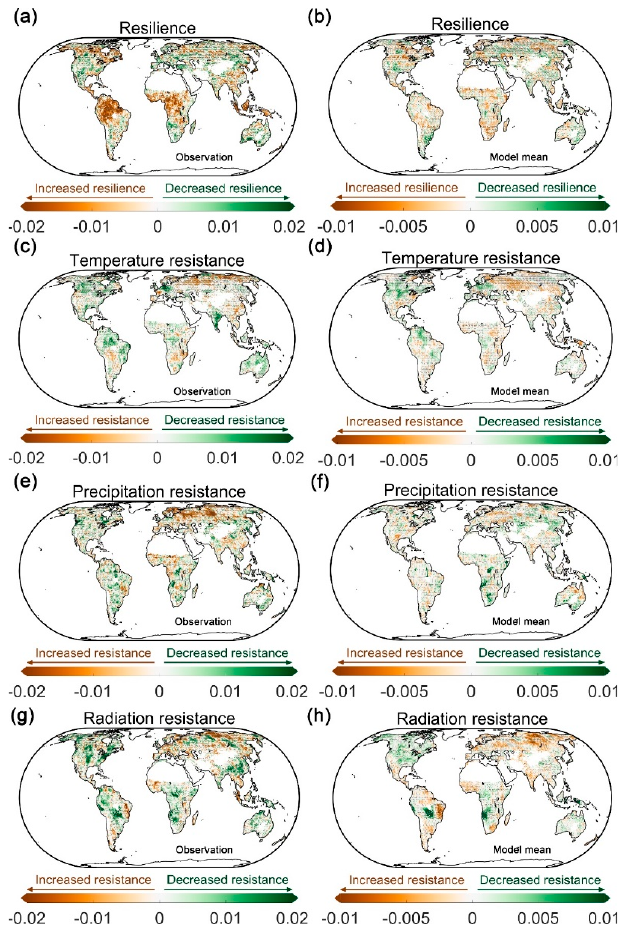
Figure 7. Spatial patterns of the changes in vegetation resilience and resistance derived from observations and models from 1982 to 2015: The changes in observation-based ( a ) vegetation resilience; ( c ) temperature resistance; ( e ) precipitation resistance; ( g ) radiation resistance. The changes in ( b ) vegetation resilience; ( d ) temperature resistance; ( f ) precipitation resistance; ( h ) radiation resistance. Linear trends of vegetation resilience and resistance are derived with sliding windows of 15 years step. If the changes in vegetation resilience or climate resistance are significant ( p < 0.05) in more than 3 models, the change in model-based vegetation resilience or climatic resistance is significant ( p < 0.05). In each subfigure, stippling indicates that the changes in observation-based and model-based vegetation resilience or climatic resistance are significant ( p < 0.05) in the grid. A positive value of the linear trend represents decreased resilience and resistance, and a negative value of the linear trend represents increased resilience and resistance.